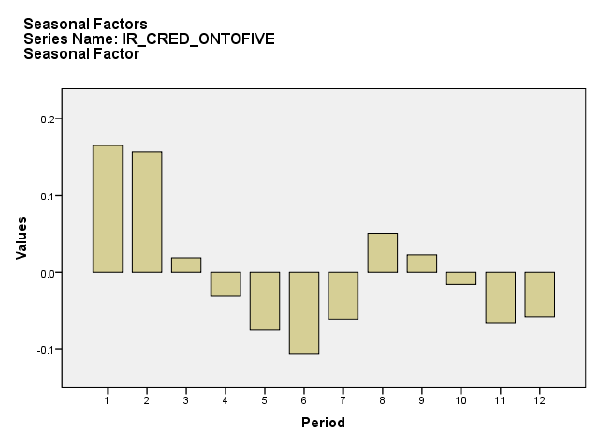
Figure 4. Seasonality of interest rates on mortgage loans with agreed maturity of one–five years.